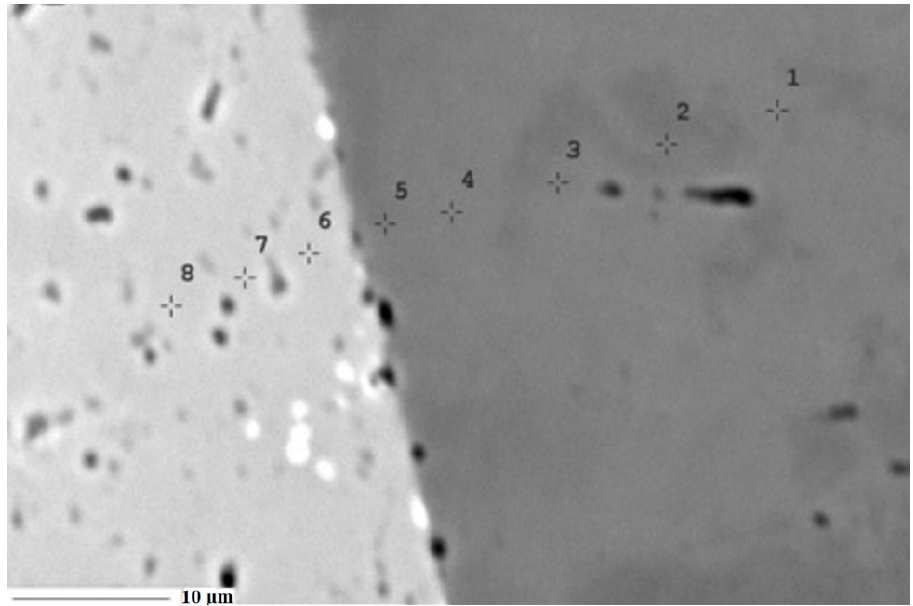
Figure 14. BSE image of sample SO14, limestone of the Karchowice Unit taken in the Strzelce Opolskie Quarry. Magn. 2000 × , 1–8—points of chemical analysis [22,24]. Table 2. Results of the microprobe measurements of a sample SO14 [22,24]. Table 1. Results of the microprobe measurements of sample S2